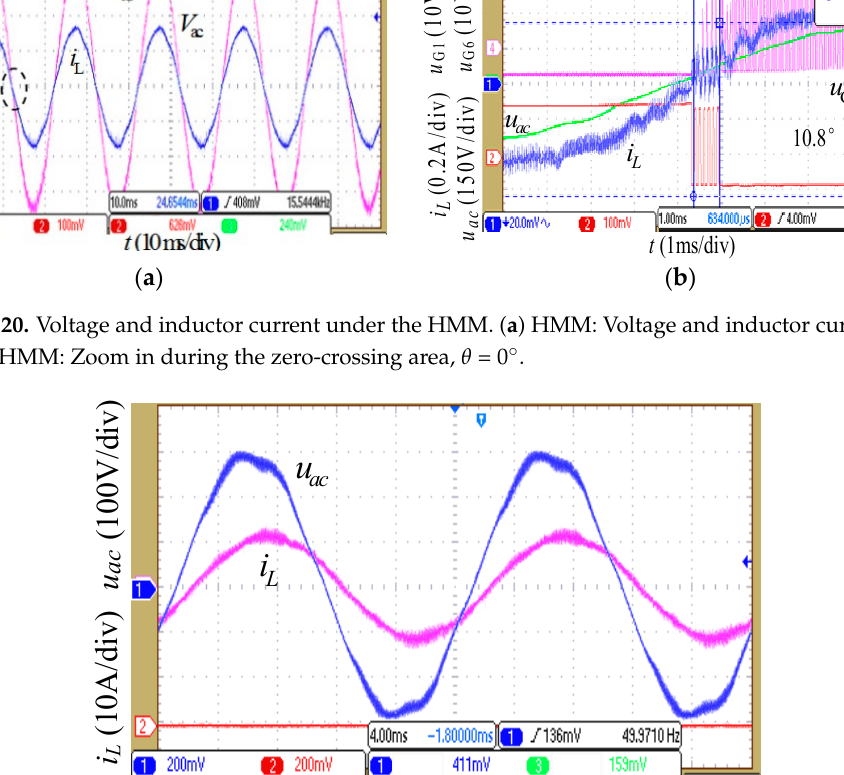
Figure 22. Common mode voltage. HMM: 2 times the common-mode voltage, θ = − 30°. In order to validate the performance of the proposed FSAPIR controller, the grid voltage with frequency variation has been simulated with a Chroma grid simulator. Figure 23 shows the experimental waveforms of the system under FSAPIR control when the frequency of current reference signal is 55.11 Hz with amplitude of 30 A. It can be seen from Figure 23 that the real current can track the reference signal with low error and the total harmonic distortion (THD) is 2.53%, which is substantially less than 5% requirement of the IEEE929-2000 standard [22].